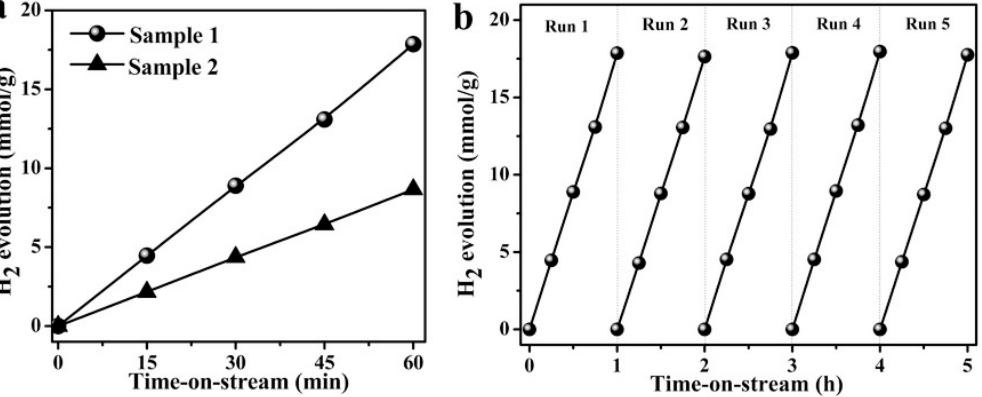
Figure 8. Ethanol was added during the synthesis of sample 1 and no ethanol in sample 2. ( a ) Photocatalytic hydrogen production of anatase TiO 2 nanosheets under UV, ( b ) Photocatalytic hydrogen production cycle experiment of sample 1 under UV. Reprinted with permission from [146].